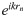
The transmission array beam pattern model.(A) A close-up view of the bat’s mouth during click emission extracted from a high-speed video (S2 Video). (B) Illustration of model formulation. The beam pattern is formed by coherent summation of the contributions of array elements along the narrow mouth opening. The phase of each element is shifted by eikrn, determined by its distance to the clicking tongue (rn) and frequency (through the wavenumber k). (C) Operation of an engineered phased array. The sound beam is directed perpendicularly from the array when all elements transmit in phase (left). The beam is steered in other directions when the elements transmit with systematically varying phase shifts (right). Our model differs from the engineered phased array in that the phase shifts at array elements are not individually controlled. Instead, it is the overall phase shift pattern that is varied by the tongue position change. (D) Shape representations of the bat head used in the BEM model implementation. The red and blue dots show the locations of the tongue and array element, respectively. (E and F) Model beam patterns of individual clicks (E) and average clicks (F) at 35 kHz, predicted using the bat head shapes shown in (D). The model average clicks were reconstructed based on Monte Carlo simulated data generated using bat and microphone locations recorded during the experiment (S1 Text). (G) Multi-frequency structure of the individual model clicks shown in (E). The plotting conventions in (E-F) are identical to those in Fig 2. BEM, boundary element method; μCT, micro computed tomography.